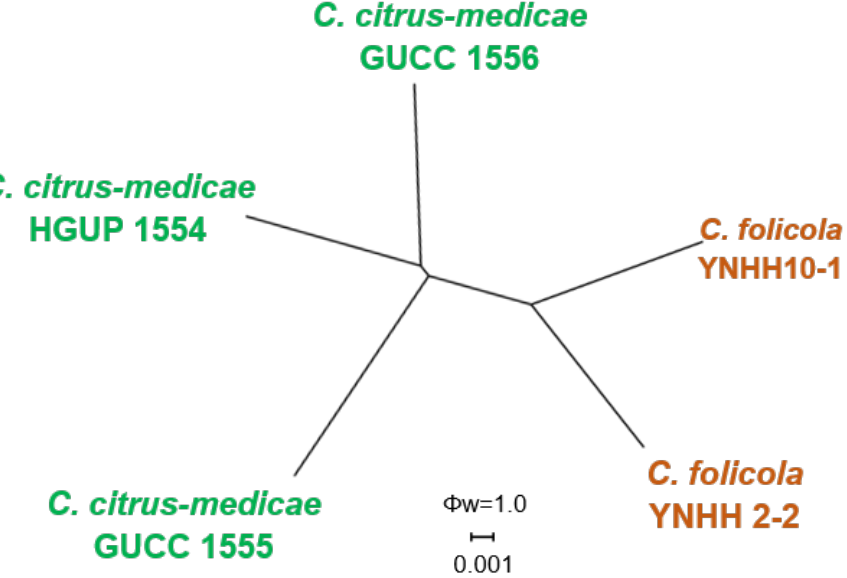
Figure 7. PHI test of C. folicola and phylogenetically related species using both LogDet transformation and splits decomposition. PHI test value (Φw) < 0.05 indicate significant recombination within the datasets.